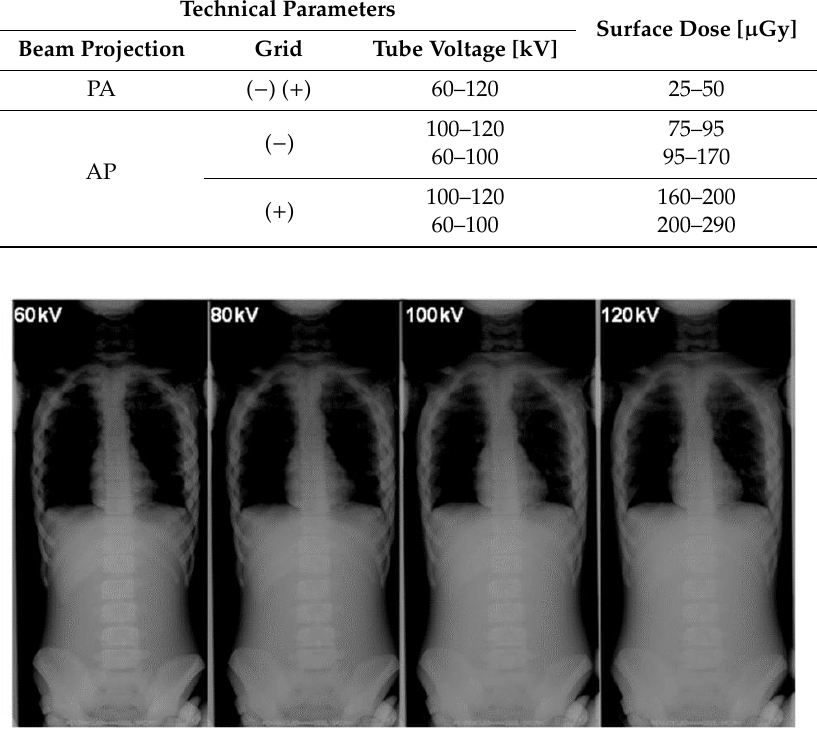
Figure 8. The differences in the phantom image contrast of full spinal radiographs using various tube voltages (focus-image-receptor distance: 180 cm, without a grid).